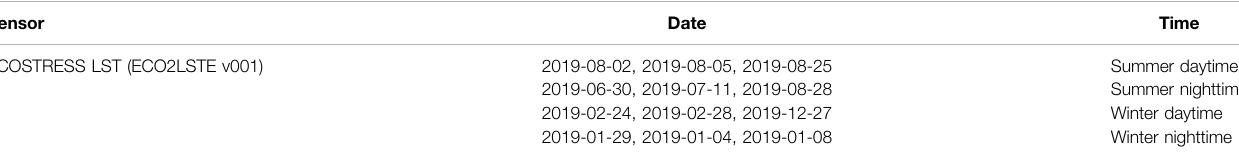
TABLE 1 | List of the selected ECOSTRESS LST products in different periods.